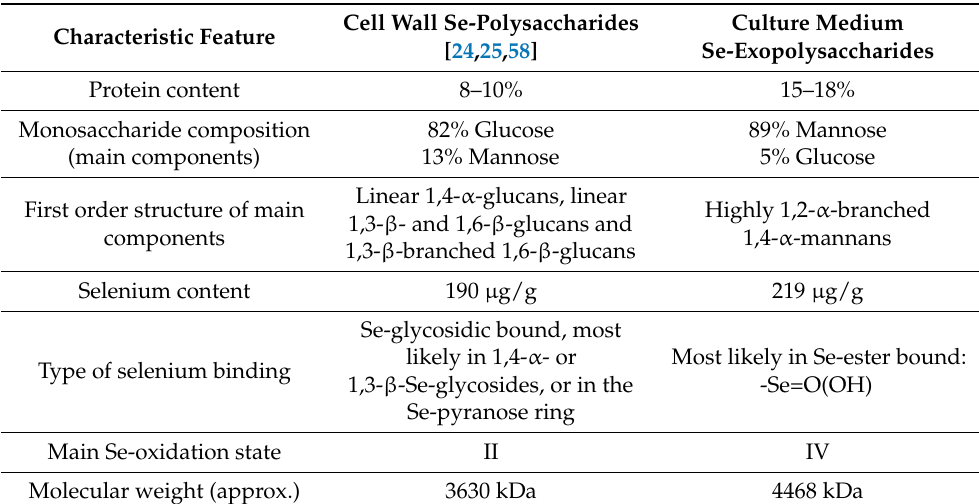
Table 3. Structural differences between the Se-exopolysaccharides secreted into the culture medium and Se-polysaccharides extracted with hot water from the mycelium of L. edodes